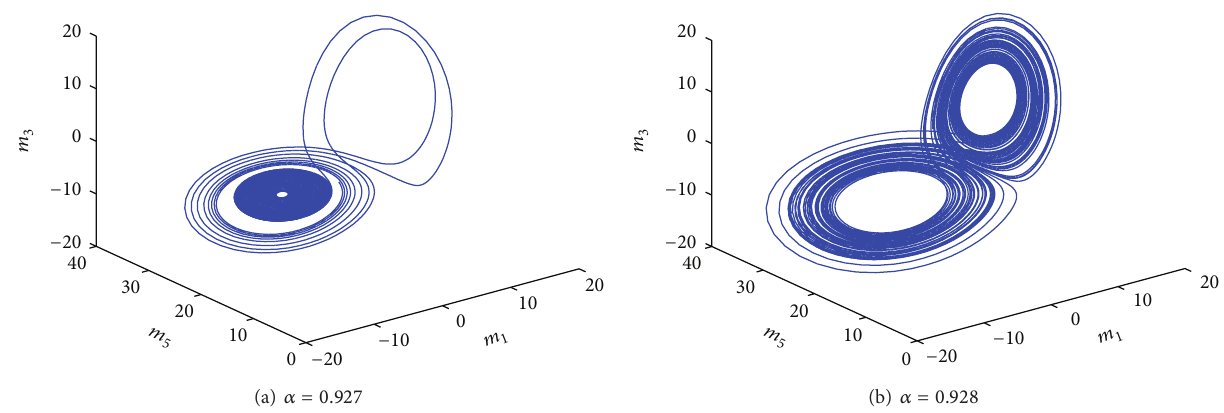
Figure 4: Phase portraits of system (5) at 𝛼 1 = 𝛼 2 = 𝛼 3 = 𝛼